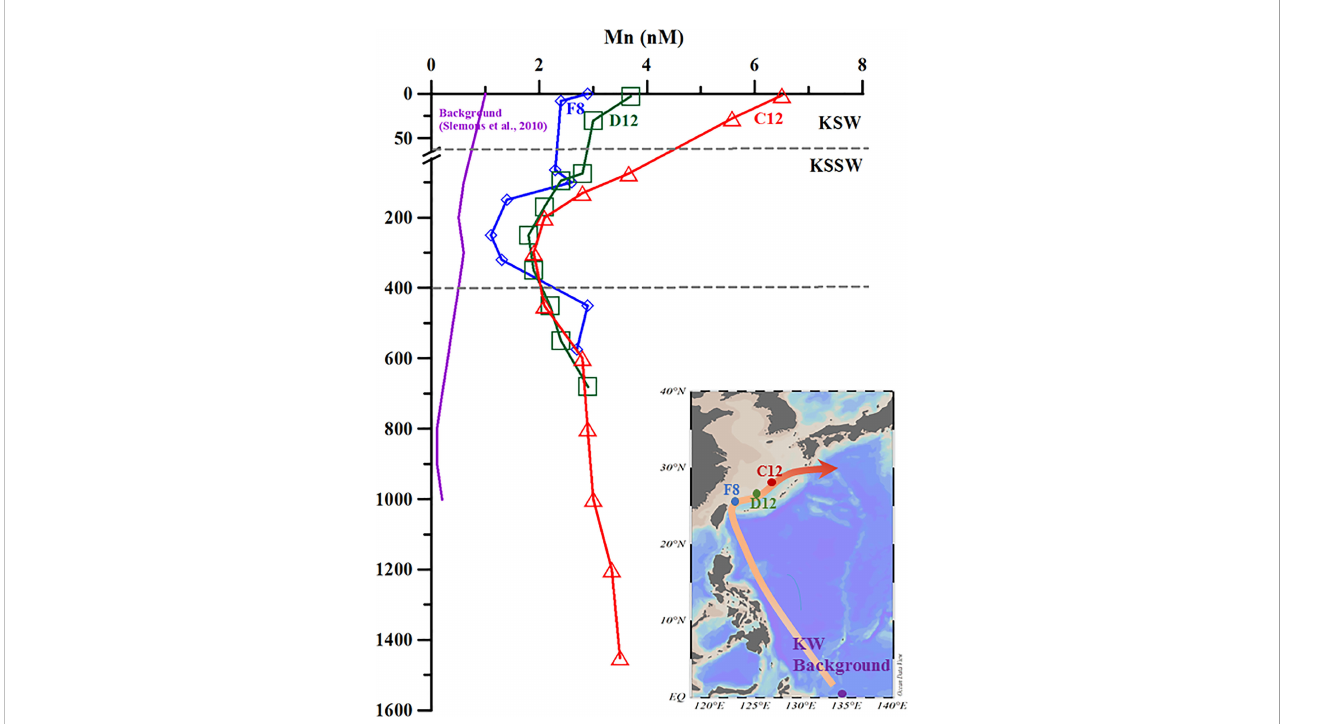
FIGURE 11 Vertical pro fi les of dissolved Mn at stations F8, D12, and C12 along the Kuroshio fl ow through the ECS edge. The positions of the stations are marked on the map. The background data of dissolved Mn in the KW is cited from (Slemons et al.,